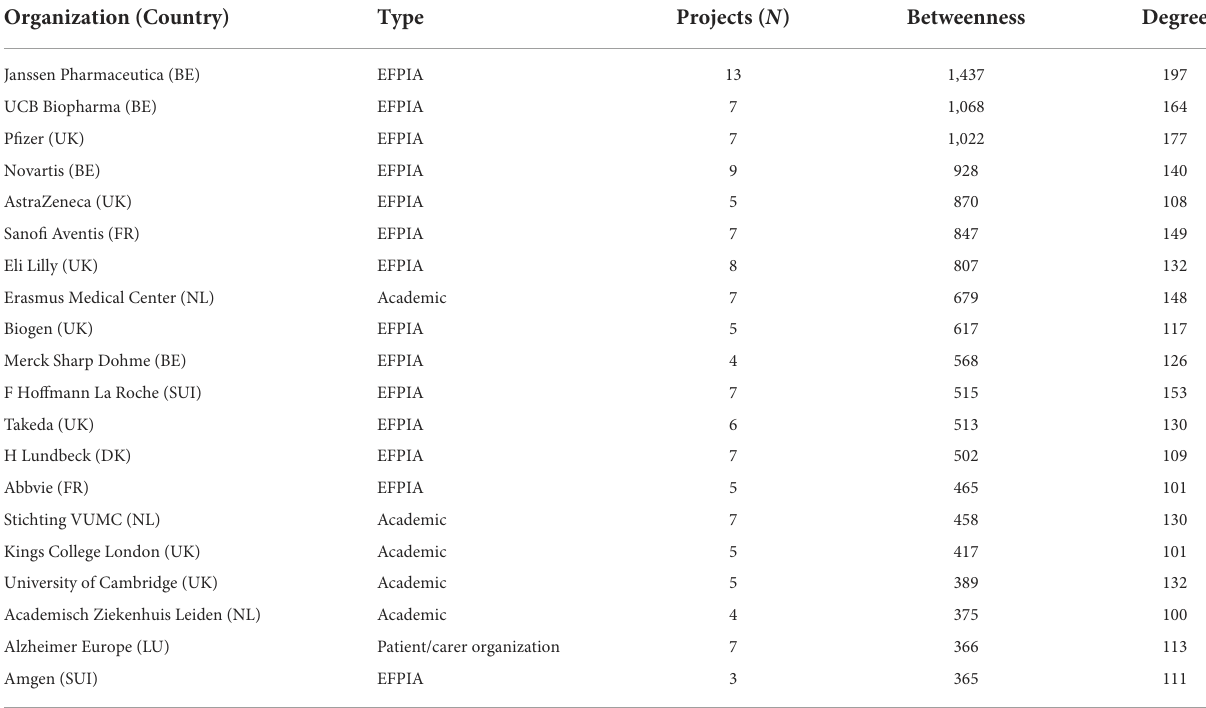
TABLE 3A Top 20 key nodes in the network analysis of the IMI NDD portfolio: Including EFPIA partners. Organization (Country)